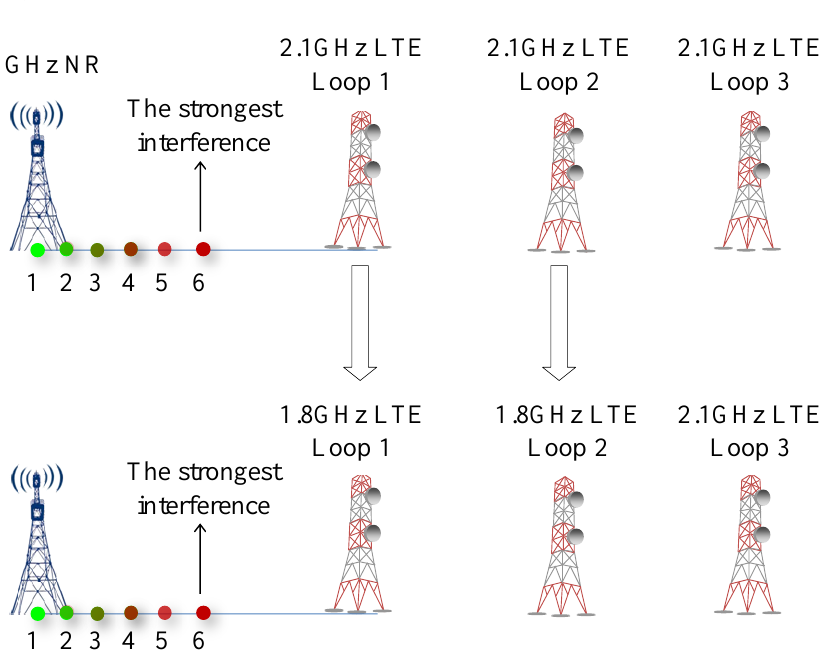
Figure 7. Schematic diagram of the